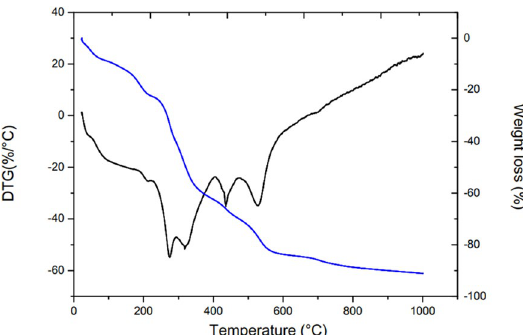
Figure 4. TG analysis of the precursor solution (solids concentration